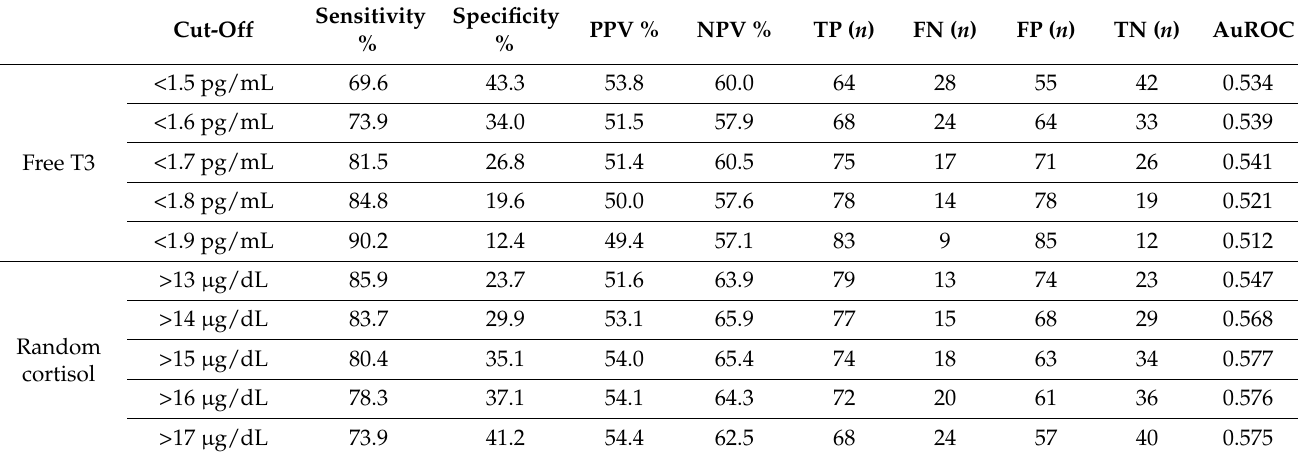
Table 3. Proposed cut-off levels for free T3 and random cortisol for predicting intensive care unit mor-